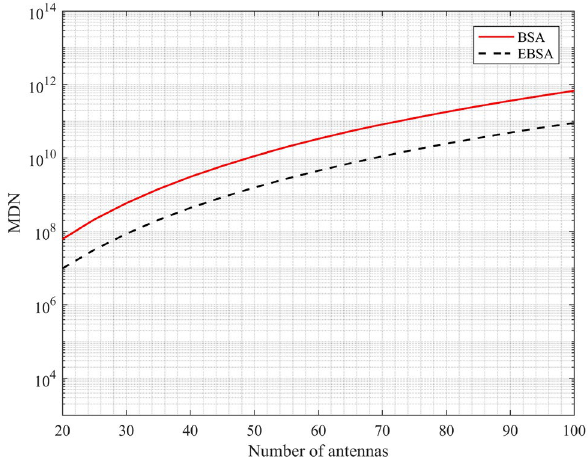
Figure 2. Computational cost